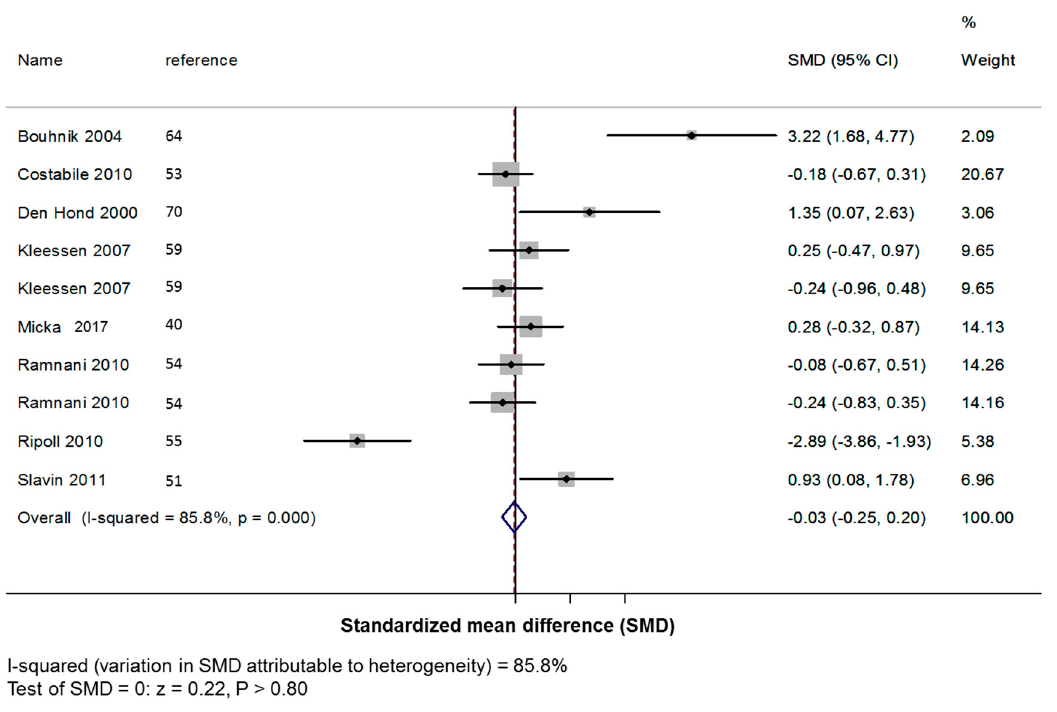
Figure 4. Forest plot for the effect of long-chain β -fructans (DP ≥ 10) on stool frequency. SMD: standardized mean difference (number of bowel movements / day); CI: confidence interval. All analyses showed heterogeneity of more than 80% ( p < 0.001), and publication bias was